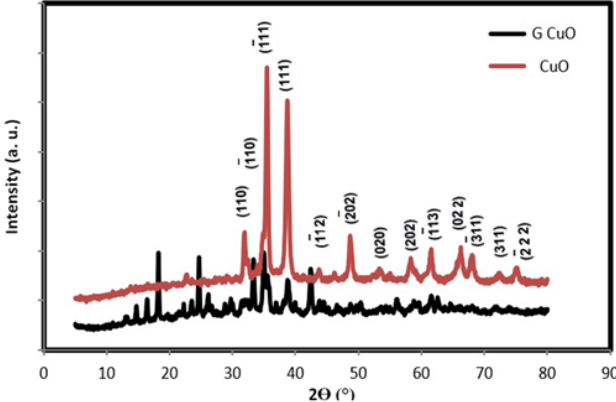
Figure 1. XRD pattern of different for CuO NPs and G CuO NPs.